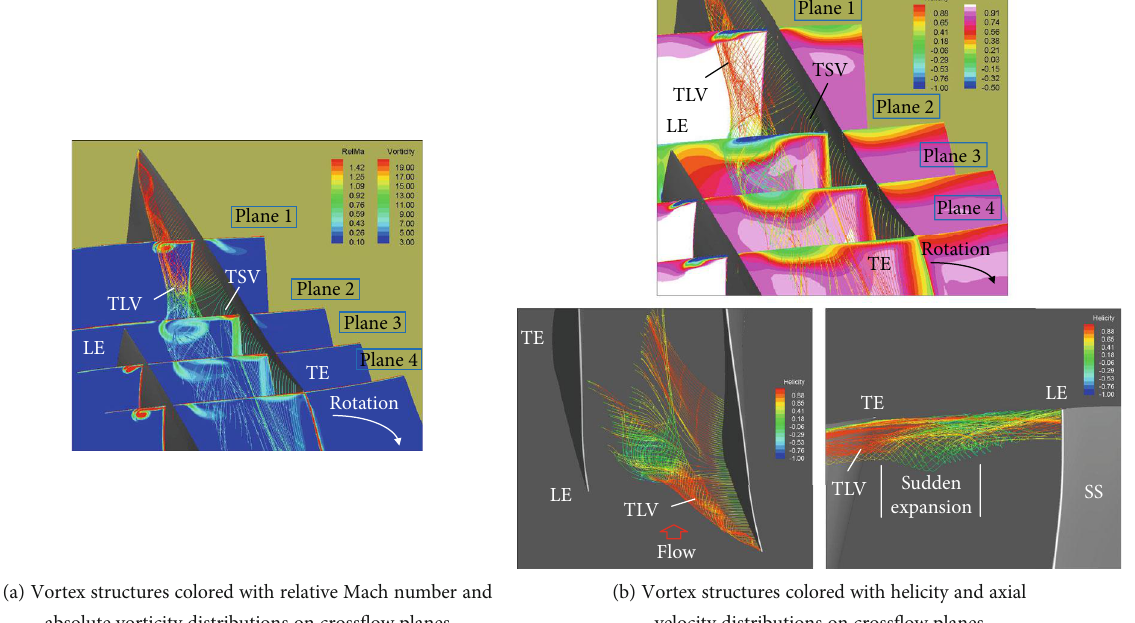
Figure 21: Characteristics of shock-induced vortex stability at near stall condition for Rotor